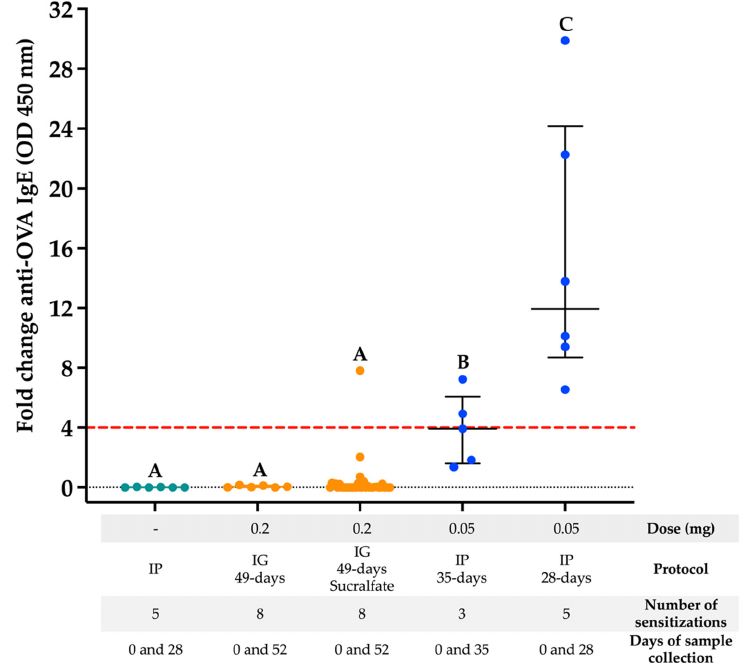
Figure 1. Comparison between the intragastric and IP routes of sensitization to OVA in BALB/c mice. The presence of anti-OVA IgE was evaluated using ELISA. Different letters represent a statistically significant difference ( p < 0.05). IG: intragastric; IP: intraperitoneal; OVA: ovalbumin. Green dots: control group; Orange dots: IG protocol ( n = 6 or 36); Blue dots: IP protocol ( n = 5 or 6); Dotted line: 4-Fold change cut-off value.